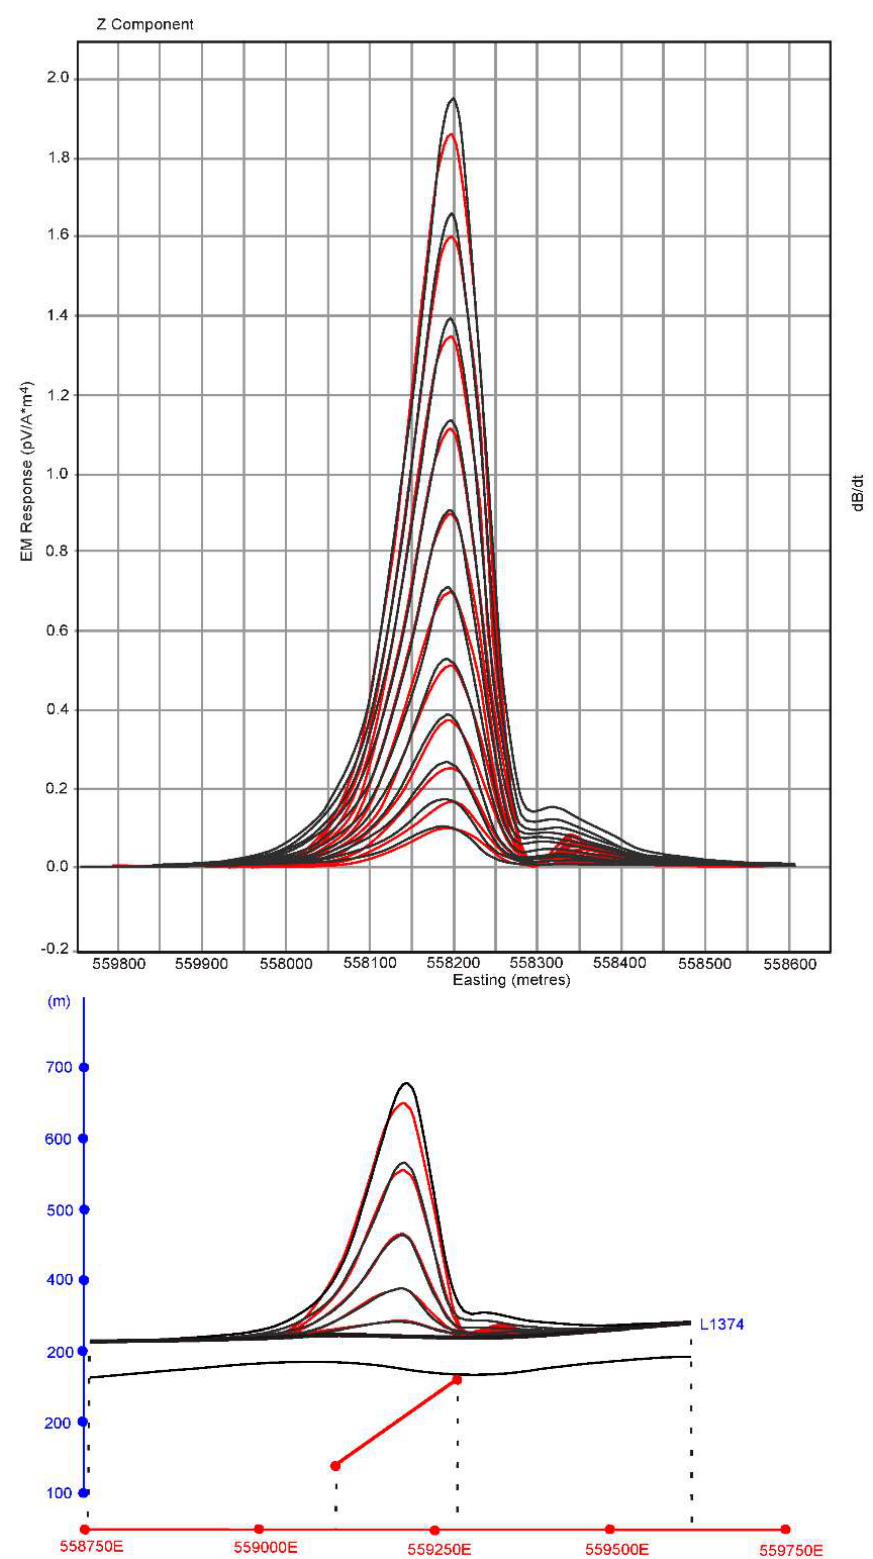
Figure 10. Maxwell thin plate modelling of the L1374-2, T-15 target, facing north. The black lines are the field data of the Z component of the VTEM flight line L1374-2 and the red lines indicate the signals from the modelled plate. The top of the modelled conductor is close to surface and dips 35° west, with a conductance of 90S. It has a strike length of 425 m.